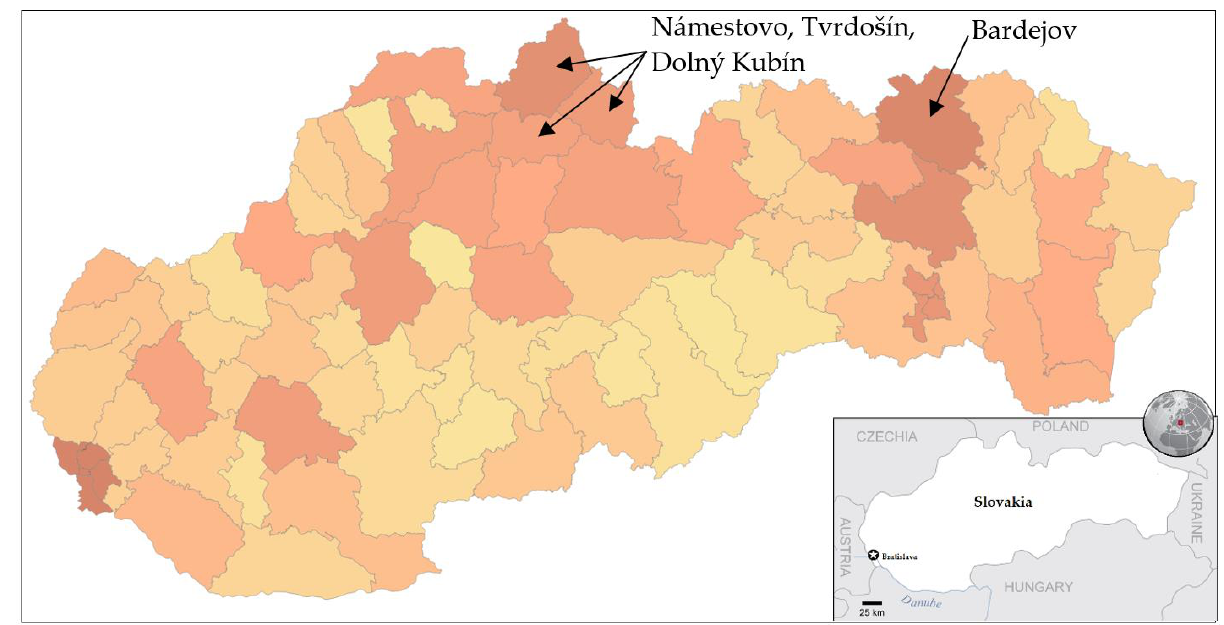
Figure 1. Pandemic situation on the day before the trial testing. Dark color characterizes districts with a higher number of confirmed positive cases by RT–PCR tests [18].